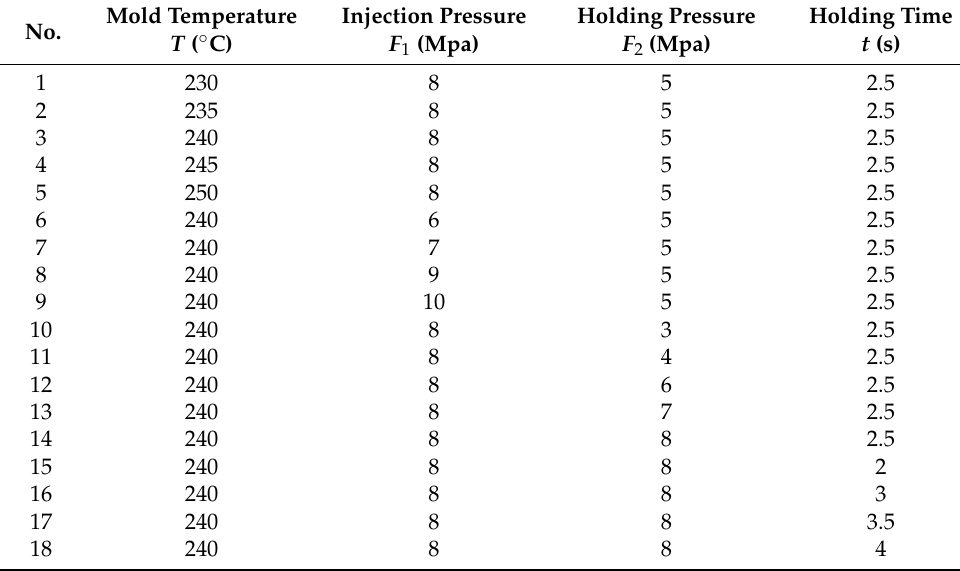
Table 3. Operating parameters for the injection molding process.